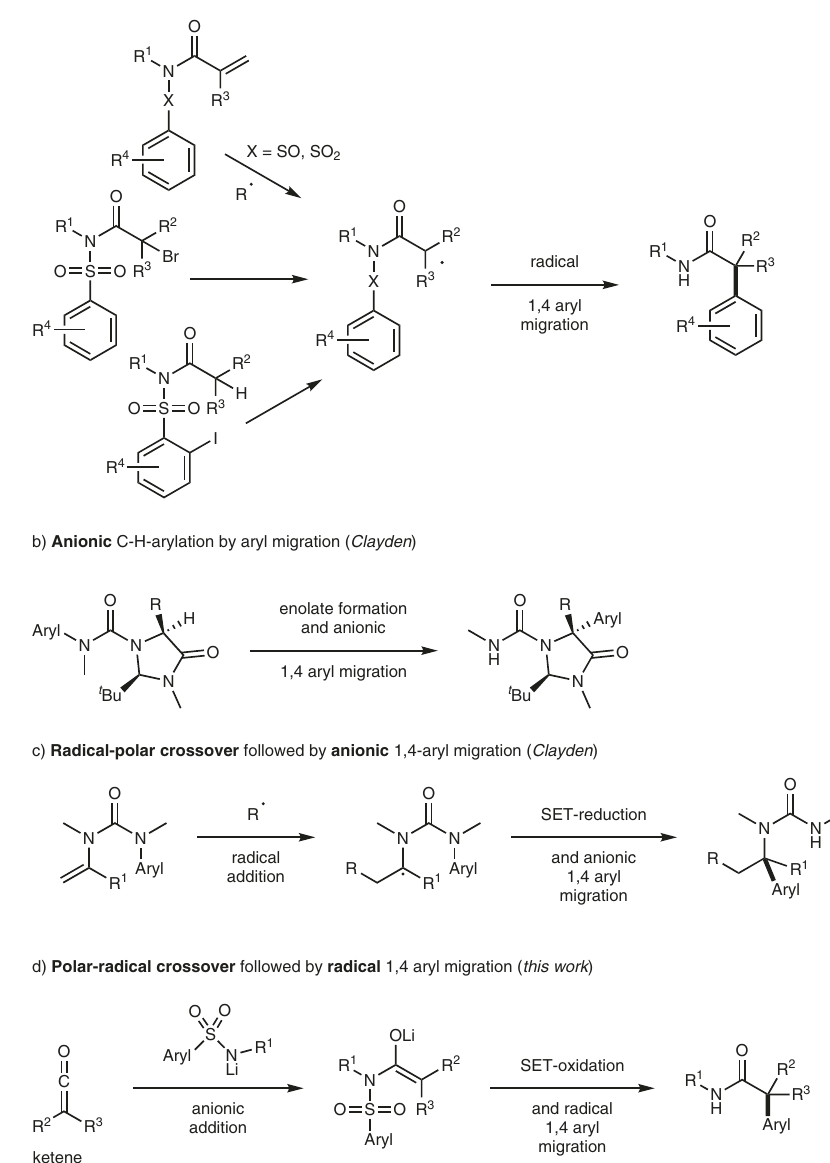
Fig. 1 Ionic and radical 1,4 aryl migration reactions — various strategies for C(sp 2 )-C(sp 3 ) bond formation. a Radical 1,4-aryl migration 63 – 68 . b Anionic migration 77 . c Radical-polar crossover migration 78 . d This work: Polar-radical crossover